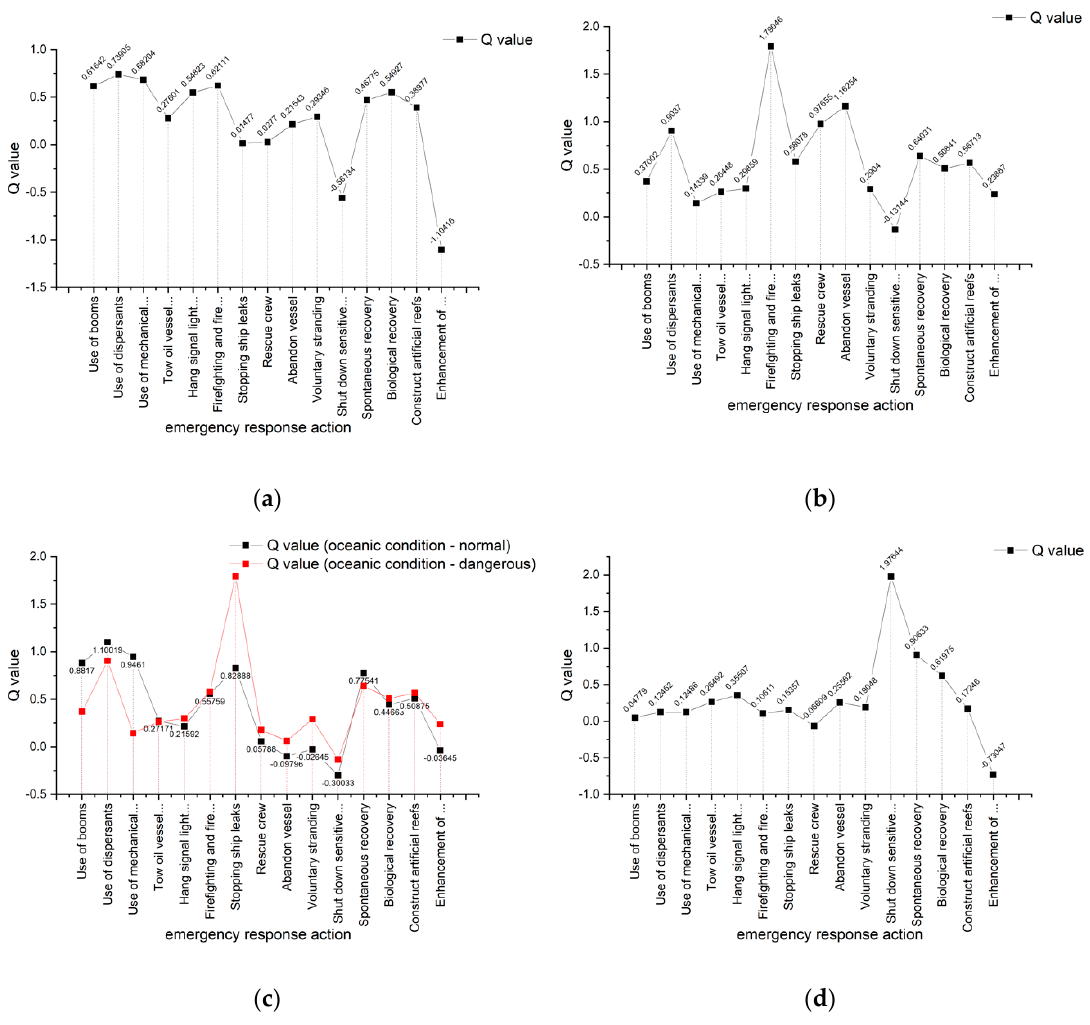
Figure 4. Policy application results for marine oil spill decision support. ( a ) Q value of the emergency response action for tanker collision scenario instance, ( b ) Q value of the emergency response action for tanker caught fire scenario instance, ( c ) Q value of the emergency response action for oil spill scenario instances with different sea condition, ( d ) Q value of the emergency response action for marine organism death scenario instance.